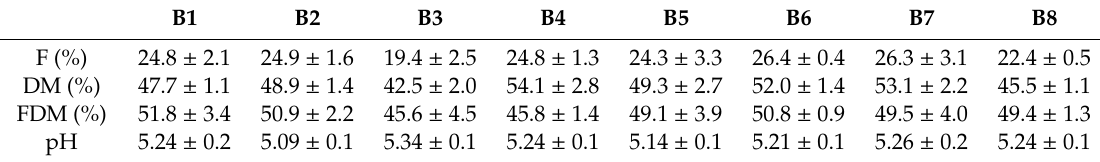
Table 2. Physicochemical properties of bryndza cheese (average values, means ± SD).